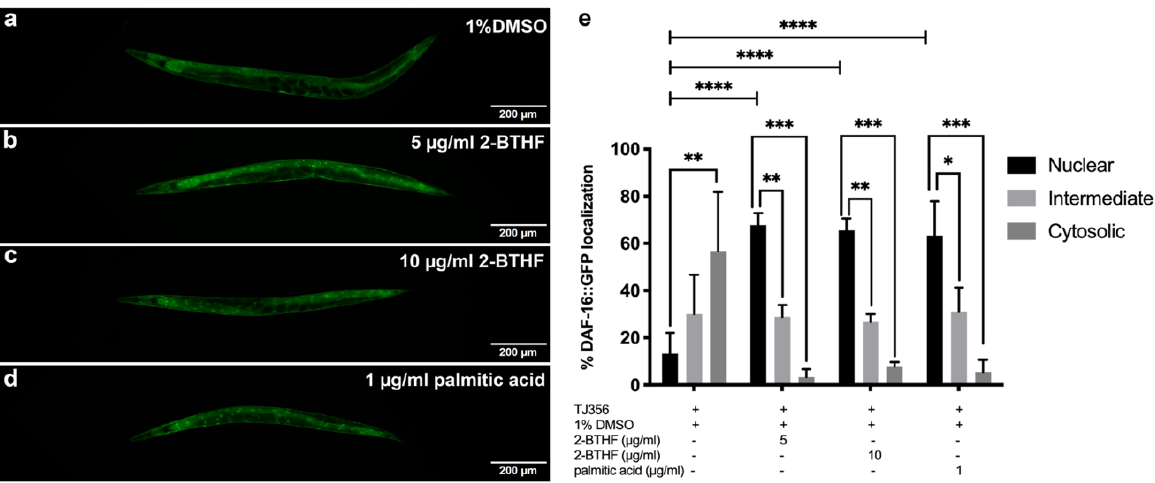
Figure 5. Effects of purified H. scabra compounds on DAF-16 nuclear translocation in transgenic TJ356 strain. DAF-16::GFP localizations in the worms treated with 1% DMSO (control) ( a ), 5 μ g/mL 2-BTHF ( b ), 10 μ g/mL 2-BTHF ( c ), and 1 μ g/mL palmitic acid ( d ) are shown. The graph shows percentages of DAF-16::GFP localization of TJ356 worms in nucleus, cytosol, or both (intermediate) ( e ). The result of nuclear translocation was analyzed by two-way ANOVA following Bonferroni’s method, * p < 0.05, ** p < 0.01, *** p < 0.001, **** p < 0.0001.